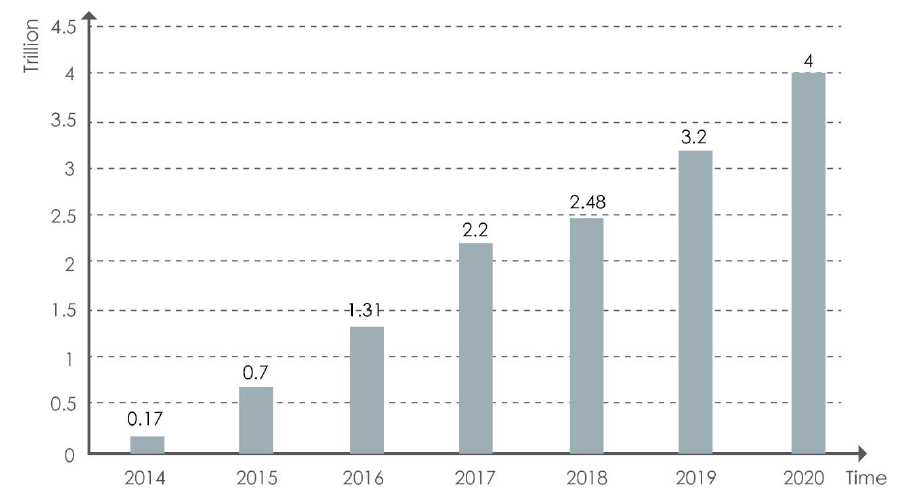
Figure 1. Market scale of smart aged-care industry in China during 2014–2020 [6].